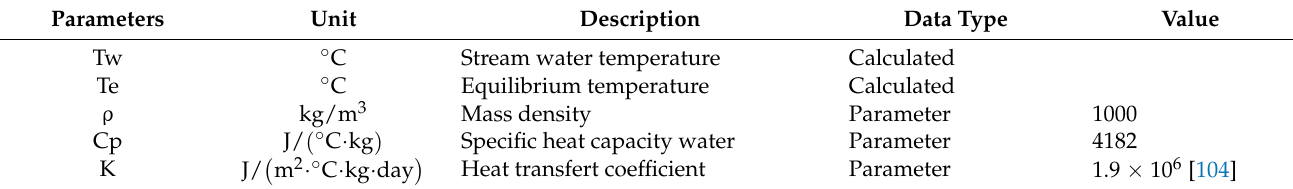
Table A4. Temperature.